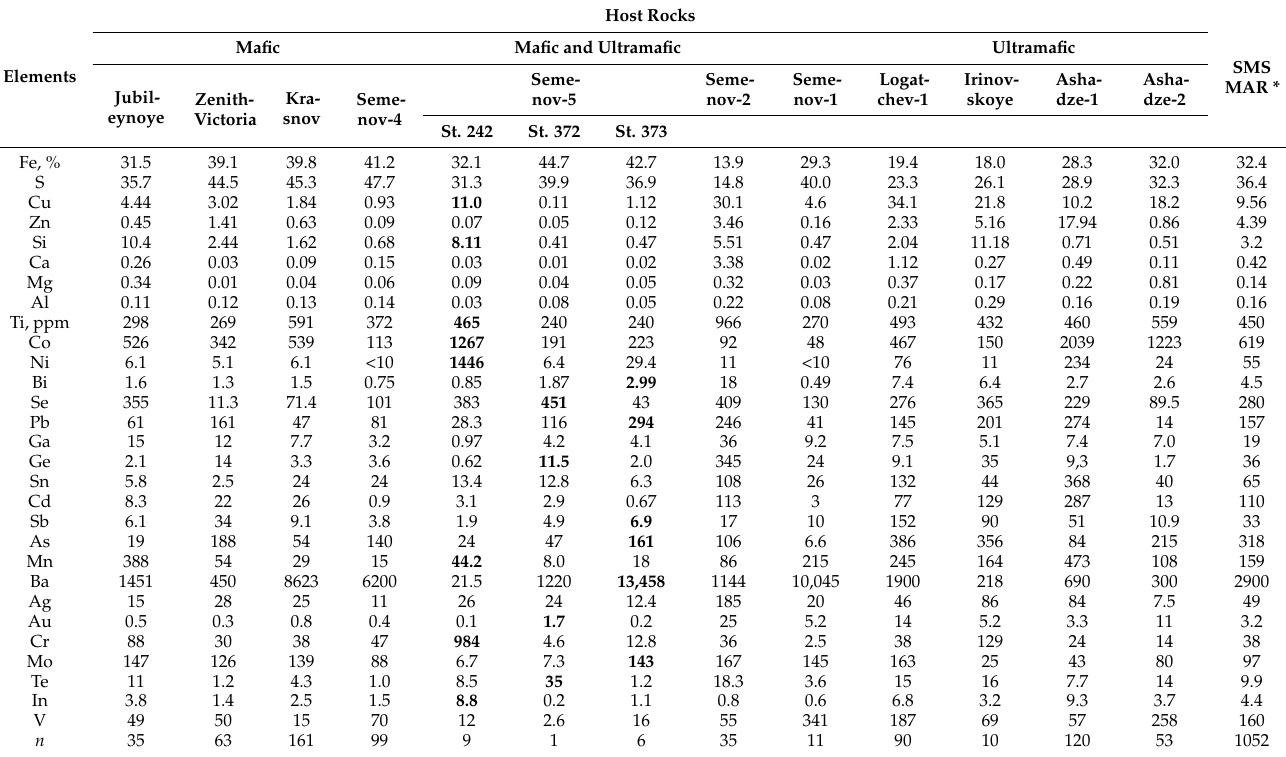
Table 8. Average content of elements in sulfide samples from Semenov-5 and another SMS at the